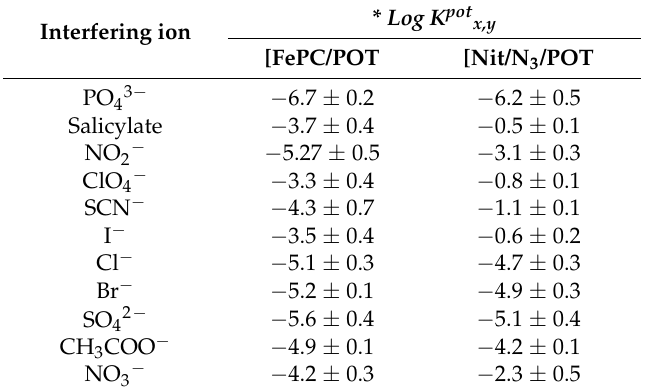
Table 3. Potentiometric selectivity coefficients, *Log K pot x,y , of the proposed screen-printed sensors. * Log K pot x,y Interfering ion [FePC/POT [Nit/N 3